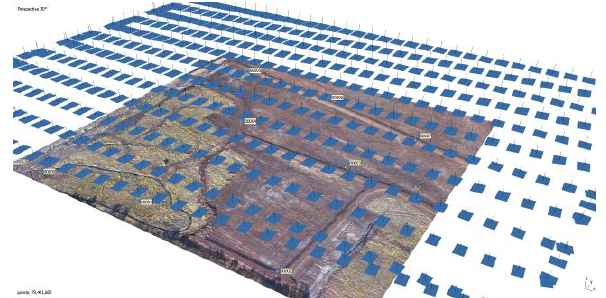
Figure 7. Flight configuration and GCP locations for moorland test area